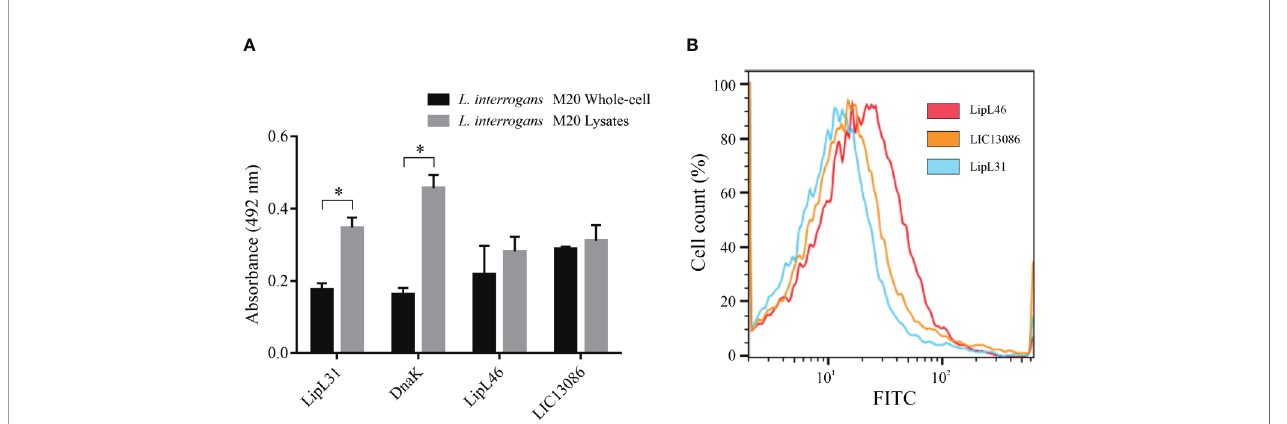
FIGURE 3 | Cellular location of native LIC13086 in L. interrogans serovar Copenhageni. (A) L. interrogans intact cells or soluble lysates were immobilized onto ELISA plates. Primary antiserum against LipL31, DnaK, LipL46, or LIC13086 were added and incubated for 1 h at 37°C. The detection was performed with HRP- conjugated goat anti-mouse IgG (1:5,000). Data represent the means ± the standard deviation of triplicates, representative of three independent experiments. (B) L. interrogans were fi xed with 2% paraformaldehyde at 30°C for 1 h and primary antiserum against LipL31, LipL46, or LIC13086 was added for 1 h at 30°C. After incubation, FITC-conjugated goat anti-mouse IgG (1:50) was added for 16 h at 4°C. Fluorescence measurements were performed in a BD FACSCanto II. *Indicates signi fi cant difference calculated by Student t- test with p-values <